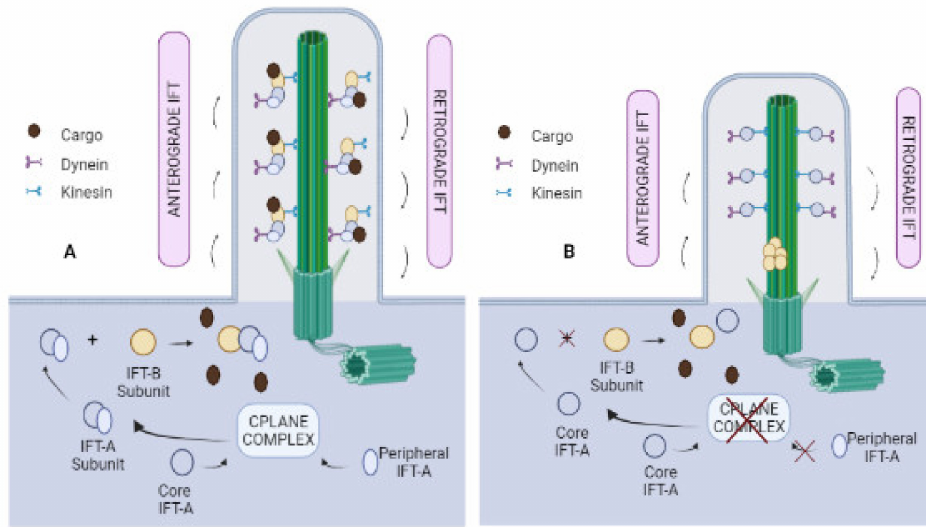
Figure 1. Relationship between the CPLANE complex and IFT. ( A ) Normal operation of the IFT when the CPLANE complex is undamaged; ( B ) IFT is truncated when the CPLANE complex is inoperative, generating shorter